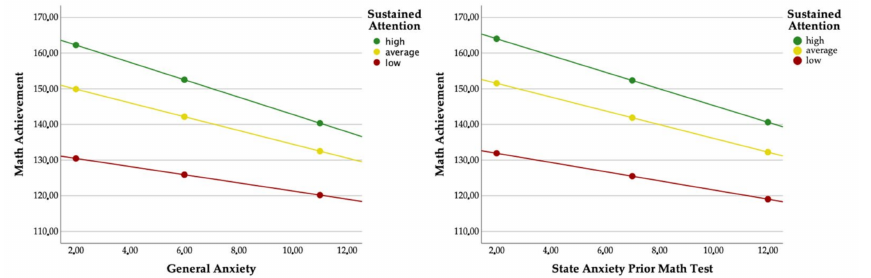
Figure 2. Moderation graphs (variables are plotted at 1 SD above and below M).